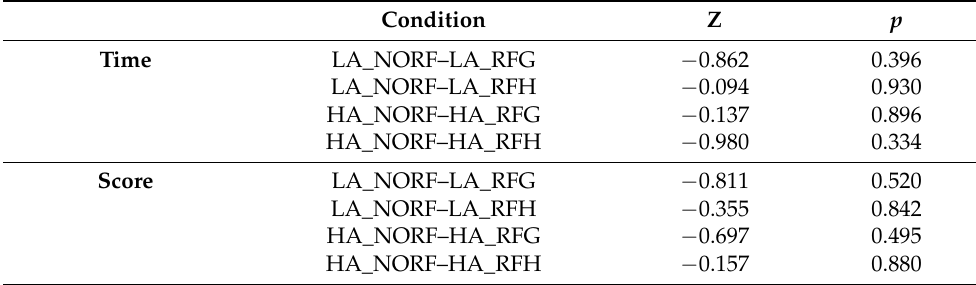
Table 12. Wilcoxon signed-rank test for the performance (score and time) scores between the rest- frames